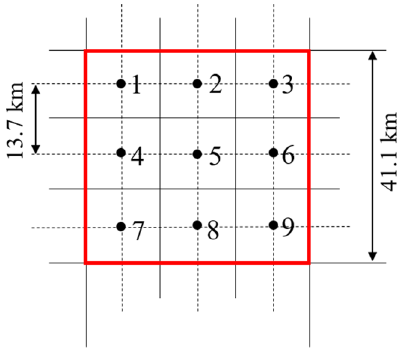
Figure 5. Illustration of a small forecast domain.